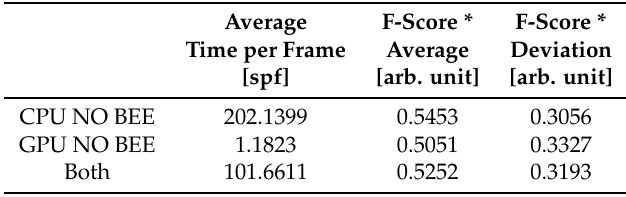
Table 3. Comparison between using GPU or CPU to compute exhaustive NCC. The average time per frame contemplates all the videos of the dataset, the units are seconds per frame. ’Both’ shows the average and standard deviation of CPU NO BEE and GPU NO BEE combined.